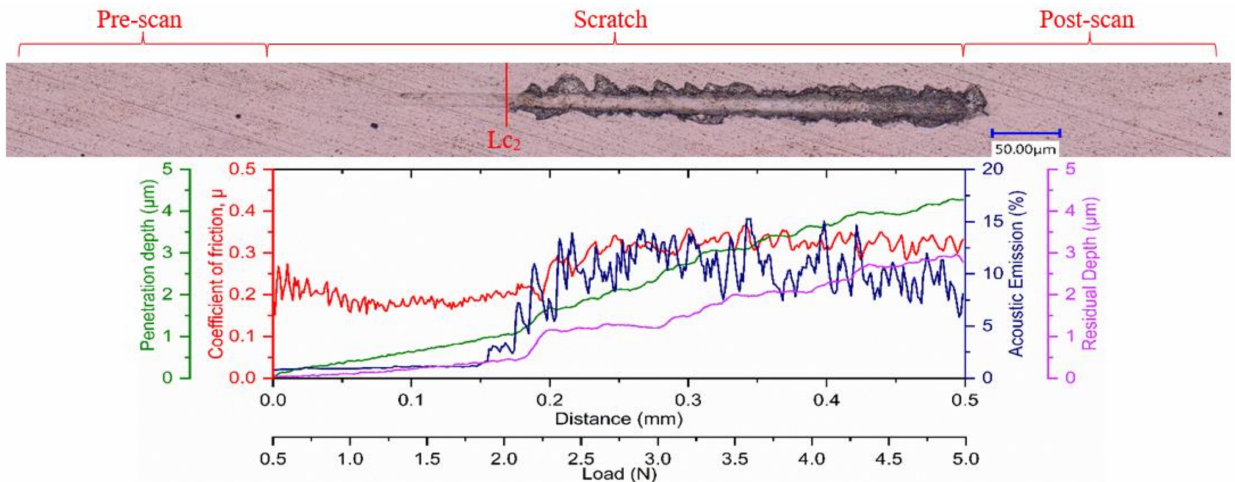
Figure 11. Ramped load scratch test data with optical images of the scratch track for Coating